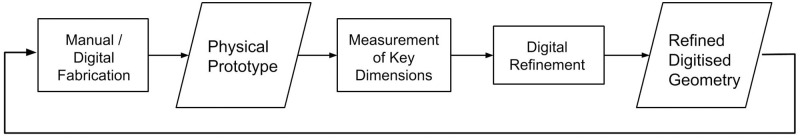
Iterative physical-digital design workflow used to develop curved crease origami face shield design.